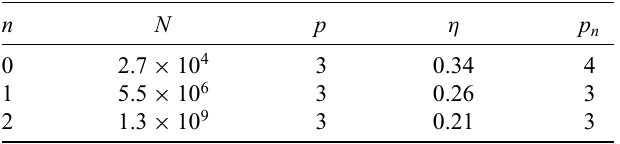
TABLE III. Optimized parameters for target Fock states 0, 1, and 2, for a precision (cid:9) = 0.3 with 95% confidence.